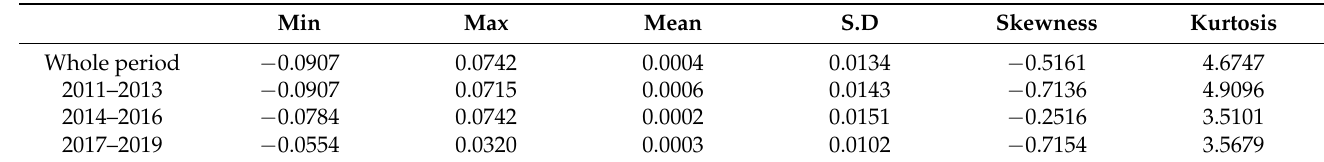
Table 7. Summary Statistics.